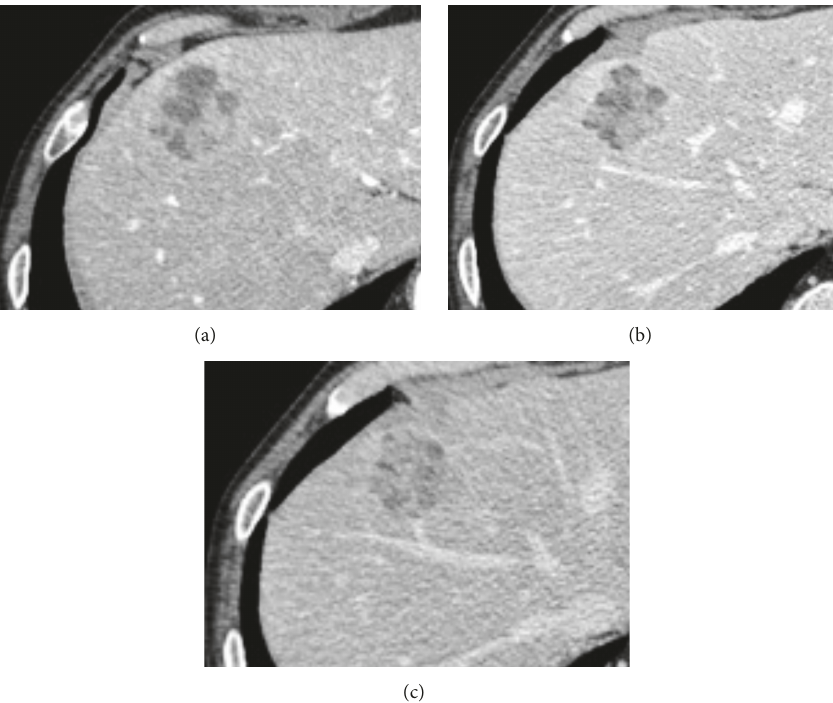
Figure 2: Images of contrast abdominal computed tomography (CT). CT showed that the tumor was slowly enhanced from the early phase to the parallel phase. (a) Early phase. (b) Delayed phase. (c) Parallel